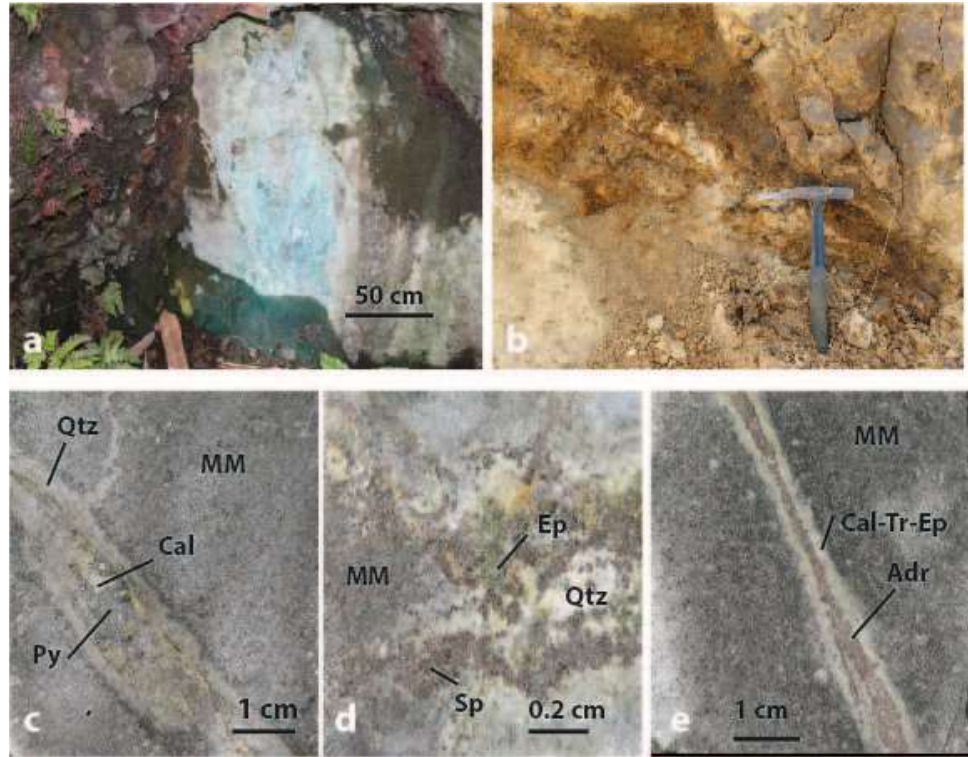
Figure 8. Photographs of ( a ) Kingston Cu-Au prospect portal showing green secondary intergrown malachite and azurite. ( b ) Quartz and pyrite in the Ilie vein (Banana Creek prospect). ( c ) Quartz (Qtz)–calcite (Cal)–adularia–pyrite vein in micromonzonite (MM) in the Banana Creek prospect. ( d ) Patch of quartz (Qtz), epidote (Ep), and sphalerite (Sp) in micromonzonite in the Banana Creek prospect. ( e ) Andradite (Adr) vein in micromonzonite surrounded by a rim of intergrown calcite-tremolite (Tr)–epidote in the Tuvau North prospect. Mineral abbreviations are after Whitney and Evans [38].